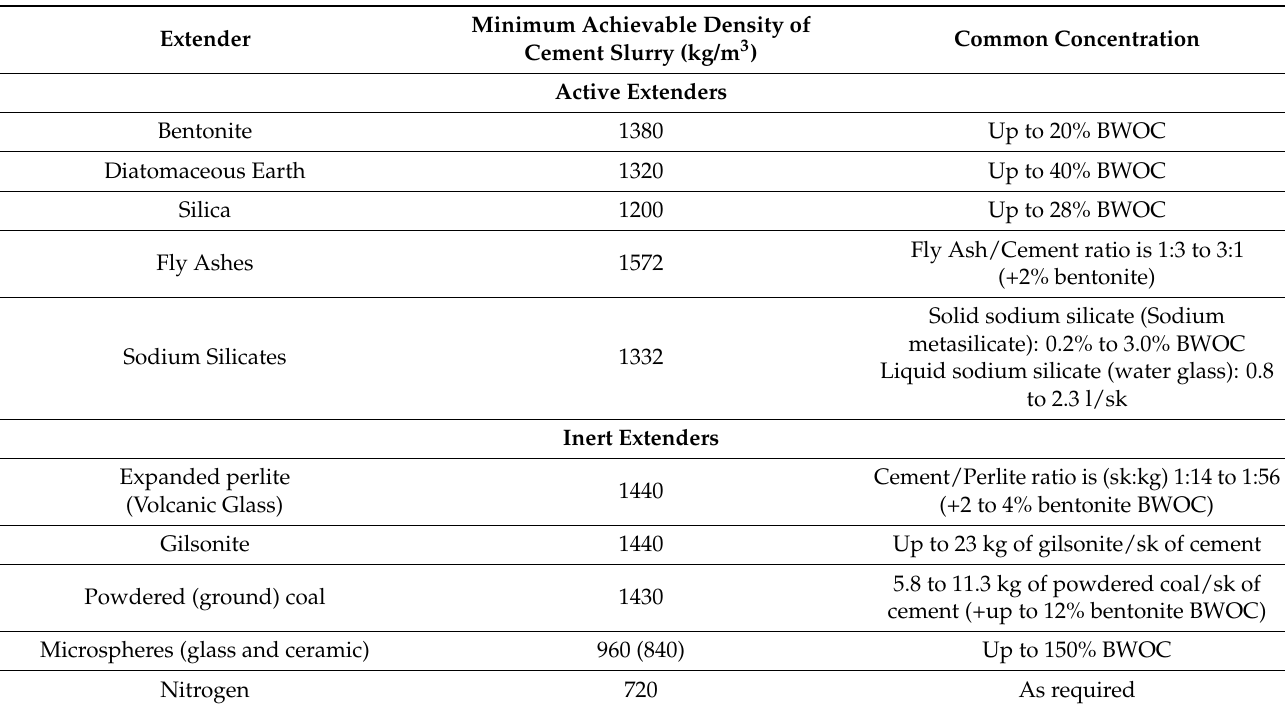
Table 7. Some common cement extenders and minimum achievable slurry density range. Minimum Achievable Density Extender